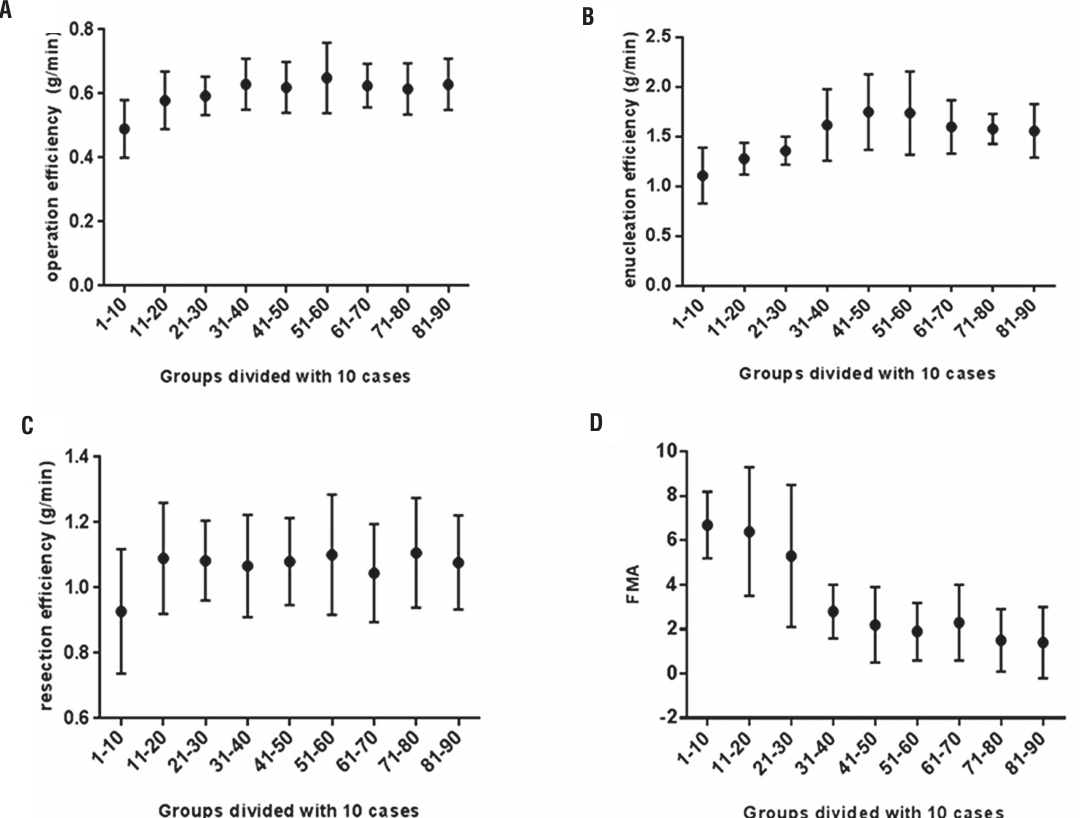
Figura 1 - (A): Comparison of operation efficiency over the number of PKERP cases performed by surgeon A (n=90); (B): Comparison of enucleation efficiency over the number of PKERP cases performed by surgeon A (n=90); (C): Comparison of resection efficiency over the number of PKERP cases performed by surgeon A (n=90); (D): Comparison of FMA over the number of PKERP cases performed by surgeon A